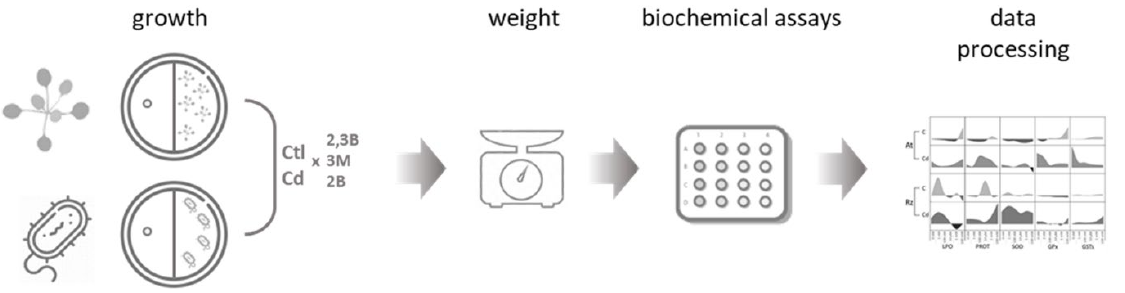
Figure 1. Schematics of the study design. A. thaliana and Rhizobium were grown in l-plates with VOCs (2,3B-2,3-butanediol, 3M-3-methyl-1-butanol, and 2B-2-butanedione) on one side and plants/bacteria on the other. After incubation (plants—14 days, bacteria—60 h), organisms were weighed (growth) and biochemical parameters (lipid peroxidation—LPO, protein—PROT, superoxide dismutase activity—SOD, glutathione peroxidase—GPx, and glutathione S-transferases—GSTs) were measured, followed by data processing and analysis; artwork own production and from https://biorender.com (accessed on 27 April 2021).